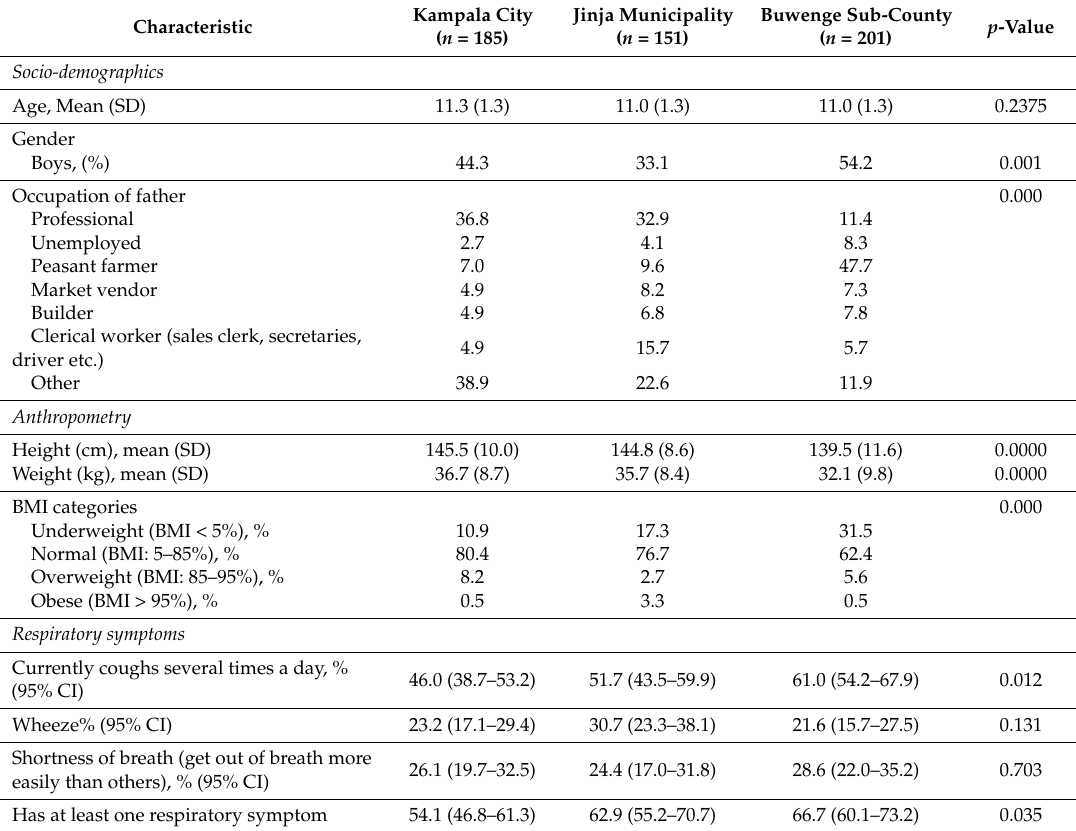
Table 1. Characteristics of study participants by site.